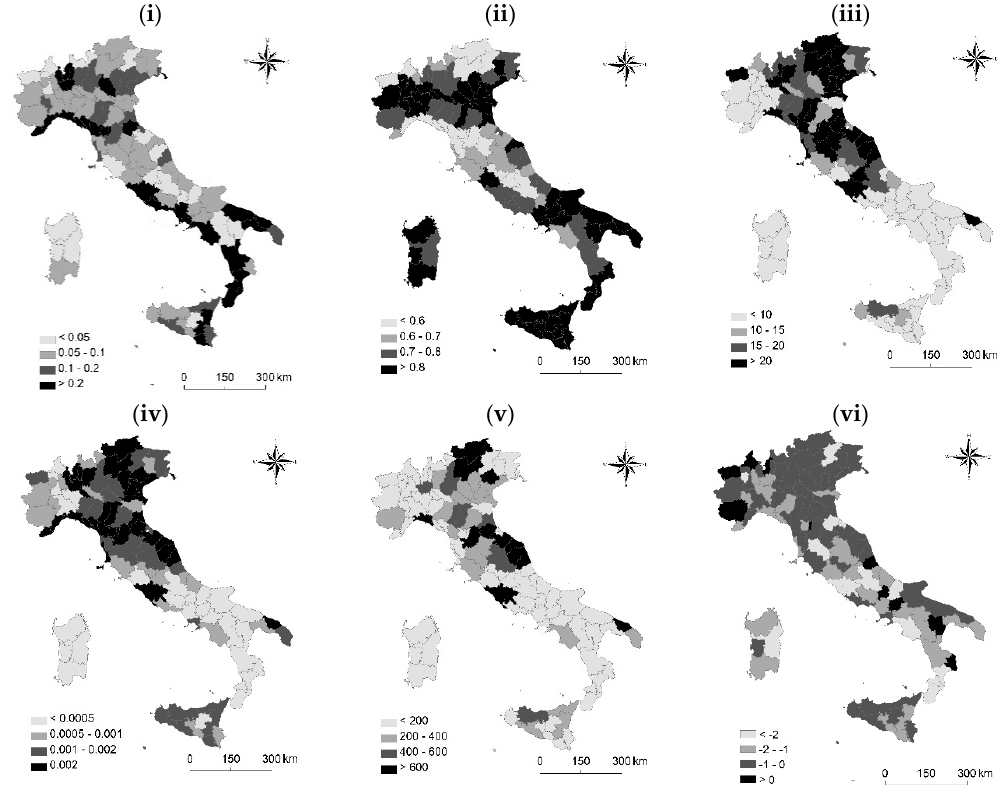
Figure 4. Selected indicators illustrating ( i ) the number of people employed in agriculture on utilized agricultural area (UAA); ( ii ) the ratio of utilized agricultural area (UAA) in the total agricultural area (TAA); ( iii ) the number of accidents in the total number of people employed in agriculture (per 1000 employees); ( iv ) the number of accidents to the total UAA; ( v ) the number of accidents to the total UAA, normalized by TAA); and, finally, ( vi ) the per cent variation between accidents occurred in 2017 (final year of investigation) and 2012 (first year of investigation).